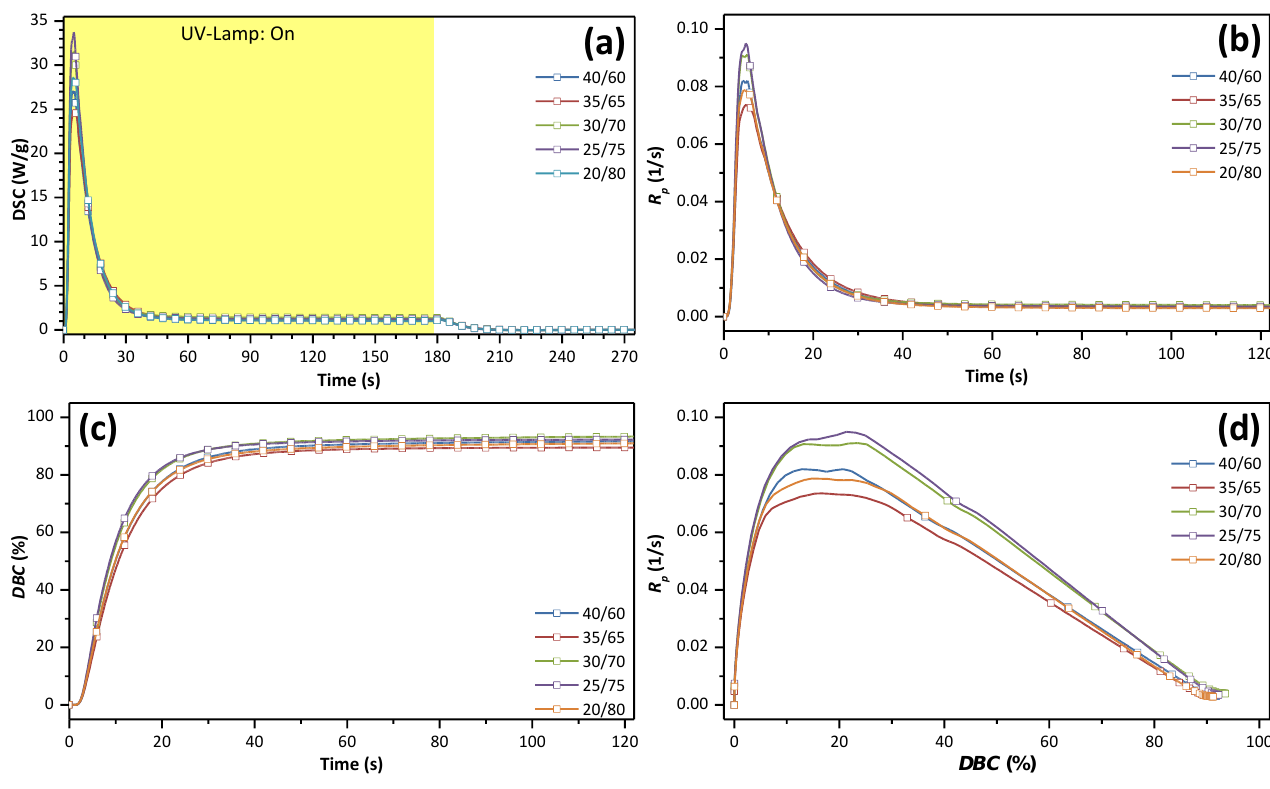
Figure 4. Photo-curing rates and conversions for UrDMA/UrA mixtures containing TPOL (1 wt.%) under N 2 atmosphere at 25 °C obtained from photo-DSC data. The intensity of the UV lamp was 1 W/m 2 . ( a ) DSC vs. time; ( b ) R p vs. time; ( c ) DBC vs. time; ( d ) R p vs. DBC . Table 3. Photo reactivity of UrDMA/UrA mixtures containing 1 wt.% TPOL under N 2 atmosphere at 25 °C obtained from photo-DSC data.